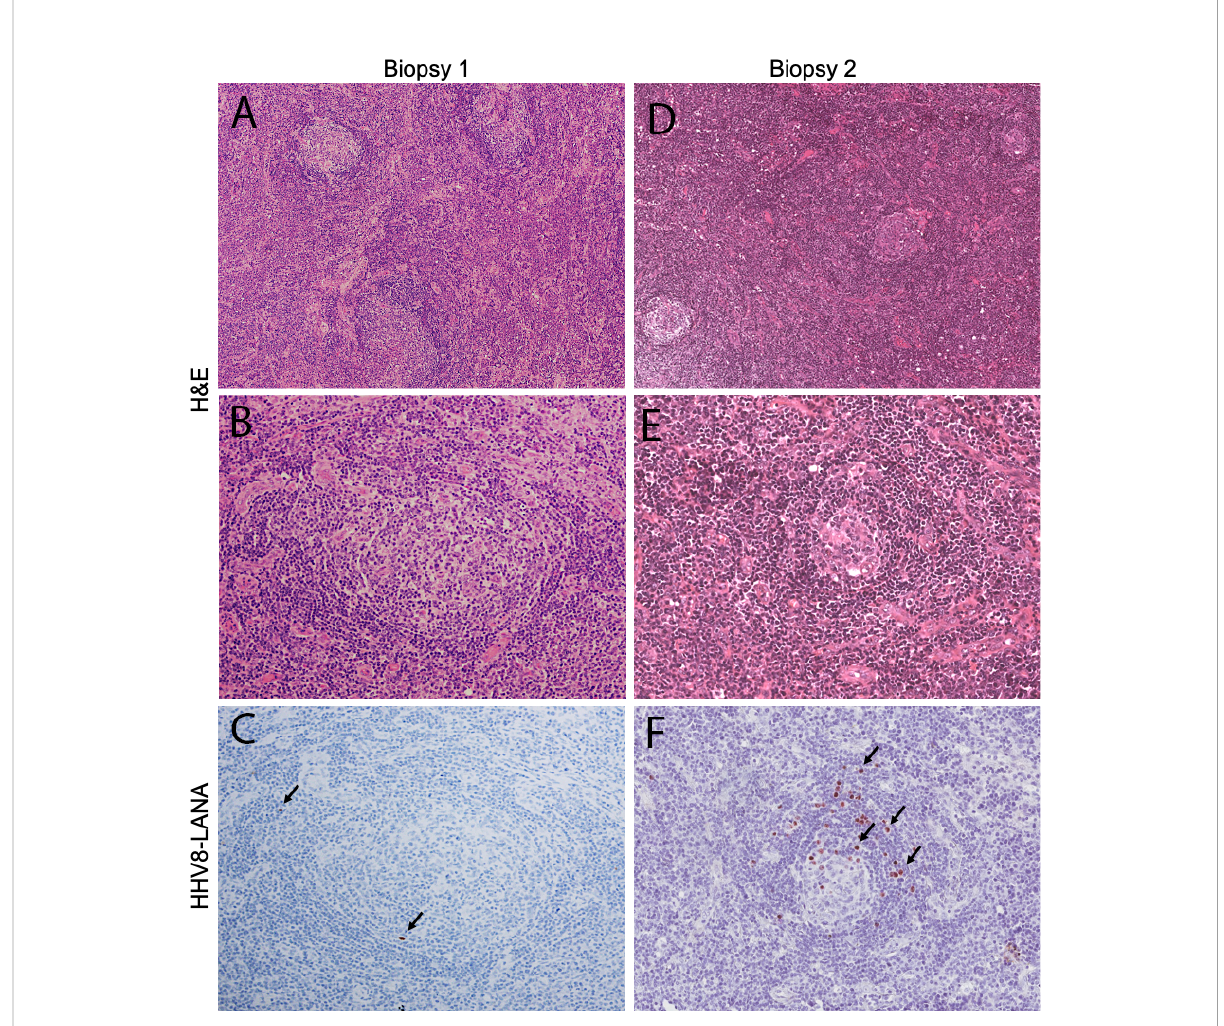
FIGURE 1 Histologic features of tissue biopsies. The fi rst biopsy (left column) shows morphologic features that are expected on the spectrum of HIV lymphadenopathy, with generally uniform appearing germinal centers and paracortical hyperplasia ( A ; objective magni fi cation x4), The cellular architecture of the germinal centers is preserved ( B ; objective magni fi cation x10) and only rare, small lymphocytes are HHV8-LANA-positive ( C ; arrows; objective magni fi cation x10). In contrast the second biopsy (right column) demonstrates small germinal centers ( D ; objective magni fi cation x4), showing stromal hyalinizaiton and decreased cellularity ( E ; objective magni fi cation x10). Numerous HHV8-LANA-positive plasmablasts rim the atretic follicles ( F ; arrows; objective magni fi cation x10), diagnostic of